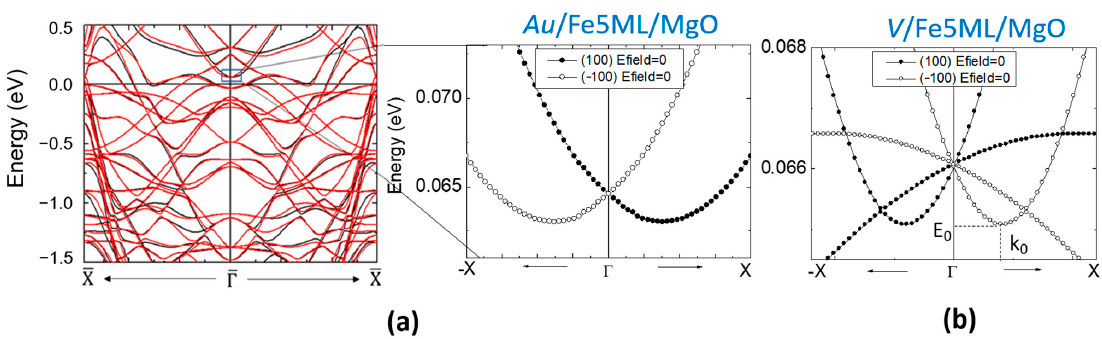
Figure 7. Energy bands oppositely shifted in k , and zooms in a narrow k and energy range (black box) - corresponding to the magnetization M (100) and M ( ( − 100), respectively, calculated for ( a ) Au/Fe/MgO and ( b ) V/Fe/MgO systems demonstrate the opposite sign of the net Rashba field 𝐁(cid:4652)(cid:4652)⃗ (cid:3019)(cid:3041)(cid:3032)(cid:3047) in the two situations (adapted from [28]). Considering this framework, our scope was to compute, explain and correlate the sign, the magnitude and the electric field dependence of the anisotropy, the Rashba coef- ficient 𝛼 (cid:3019) , and the Dzyaloshinskii–Moriya (DMI) interaction parameter in different types of X /Fe/MgO(001) systems in which the variable layer was X (where X = V, Au, Ag, Pd, MgO, etc.). A typical example of such kind of result is depicted in Figure 8, corresponding to the ab-initio analysis of the Au/Fe(5ML)/MgO system. Figure 8. Electric field dependence of the surface anisotropy K u (PMA), 𝛼 (cid:3019) and DMI, here for the Au/Fe(5ML)/MgO system–(adapted from [28]). The zero field values: K u (E-field = 0) = 1.91 MJ/m 3 and DMI (E-field = 0) = 1.67 mJ/m 2 will be further used in micromagnetic simulations (see Section 3.2.2). We also studied the influence of a monolayer of different metals, e.g., Pt, Au or Pd inserted at the top interface between Fe and MgO. We observed that in the case of a Pt, the PMA, the DMI and their variation with respect to an external electric field are always enhanced, independently of the nature of X . The most significant effect has been found for the Au/Fe(5ML)/Pt(1ML)/MgO system. Here, the Pt ad-monolayer amplifies the PMA by an order of magnitude, from 1.91 to 15.77 MJ/m 3 , the DMI from 1.67 to 2.27 mJ/m 2 , and the variation of PMA with E-field roughly by a factor of 2. These results indicate promis- ing strategies for tailoring the PMA, DMI and their response to an electric field, very im- portant issues for micromagnetic properties and control, as we will illustrate later. Therefore, the ab-initio calculations will be very important for a further micromag- netic analysis of skyrmionic nanomaterials. The opposite sign of the Rashba coefficient 𝛼 (cid:3019) in different systems would determine the opposite signs of the Dzyaloshinskii–Moriya